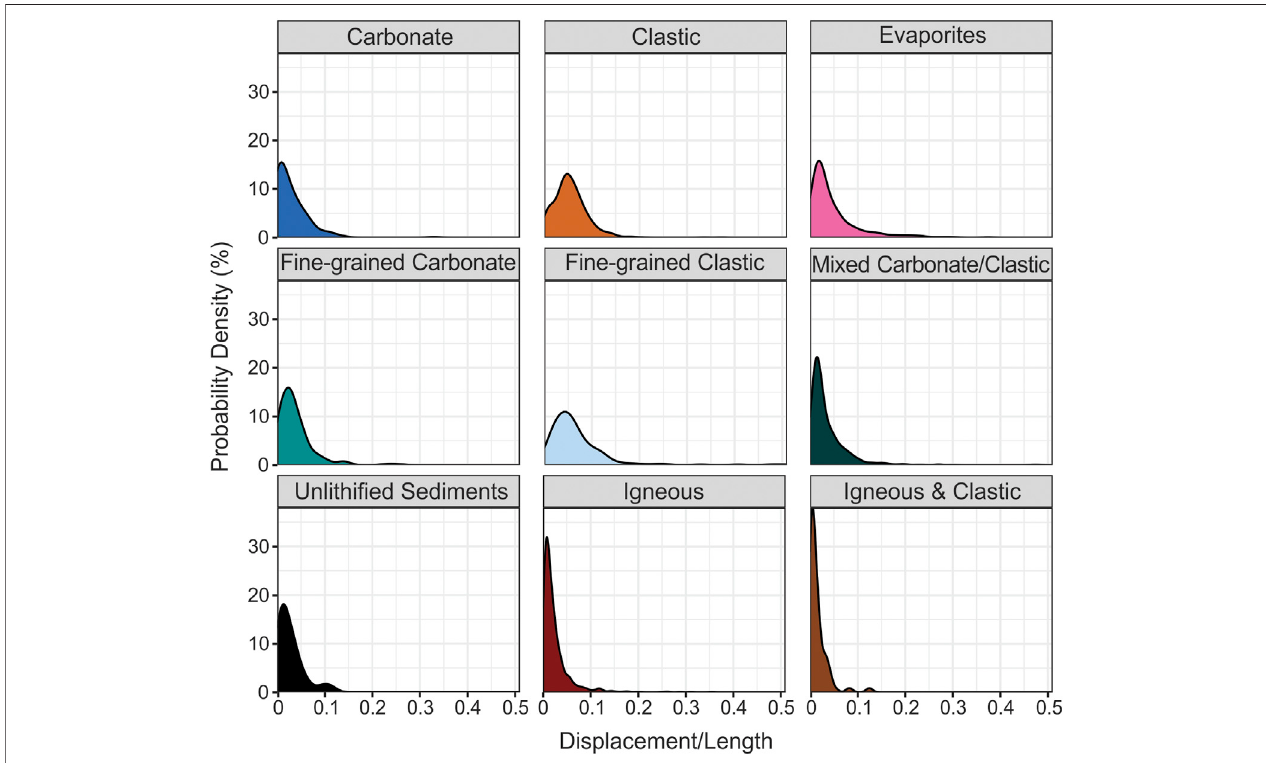
FIGURE 9 | Density estimates of the D/L value of faults with host rocks of different lithologies included in our dataset, including carbonate, clastic, evaporites, fi ne- grained carbonate, fi ne-grained clastic, mixed carbonate/clastic, unlithi fi ed sediments, igneous, and igneous/clastic. Peaks in the density plot are at the D/L values with the highest